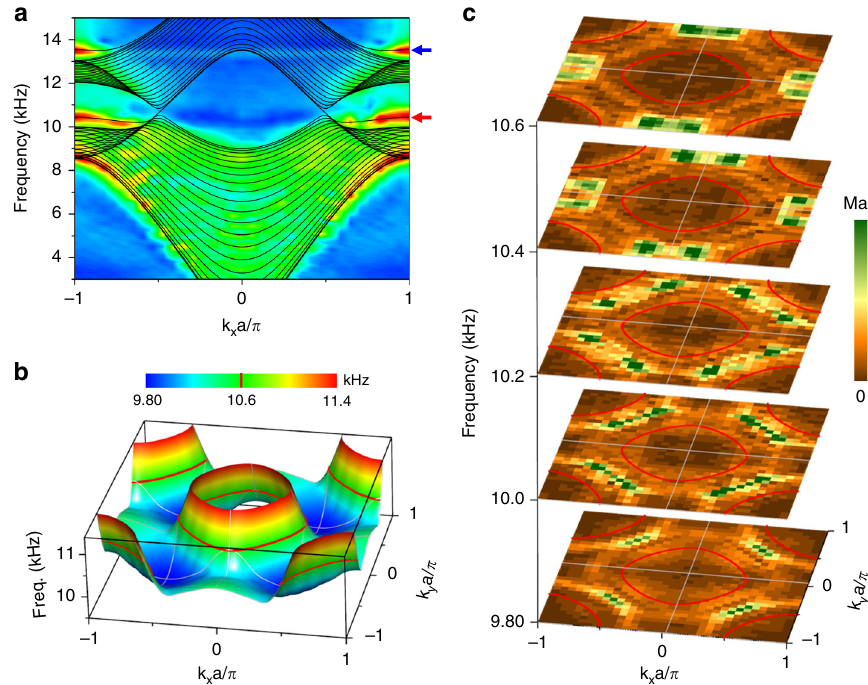
Fig. 3 Phononic drumhead surface states. a The projected dispersion for k y a = 0 showing the surface states of the PC. The red arrows and blue arrows denote the drumhead surface states and high-frequency surface states, respectively. b A 3D view of the simulated dispersion for the drumhead surface states. The red lines show the equifrequency contour at 10.6 kHz. c Cross sections for the measured drumhead dispersion. The measured results are consistent with the variations of the simulated